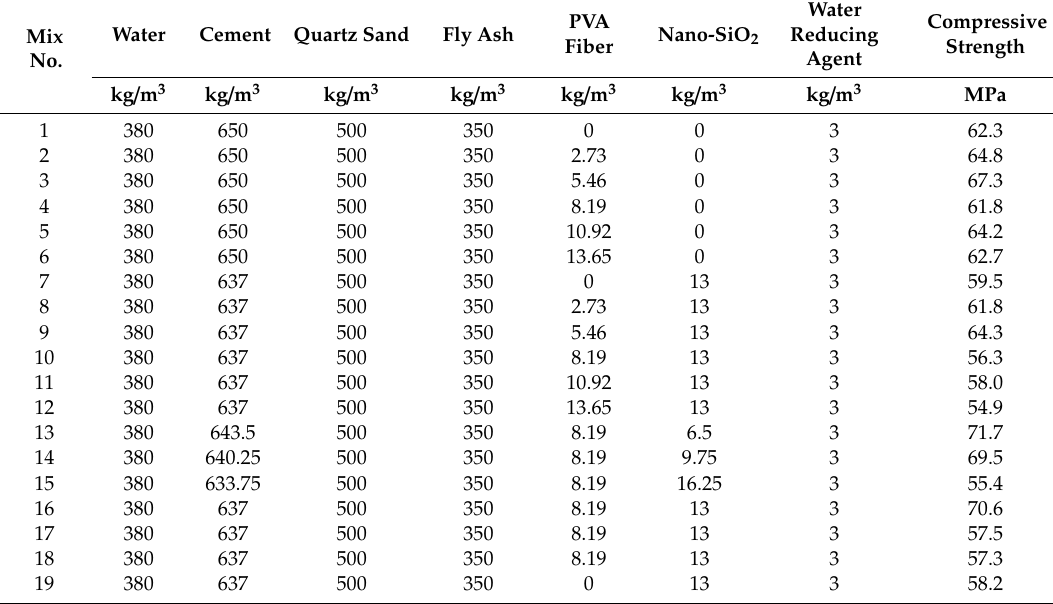
Table 1. Mix proportions of polyvinyl alcohol (PVA) fiber cementitious